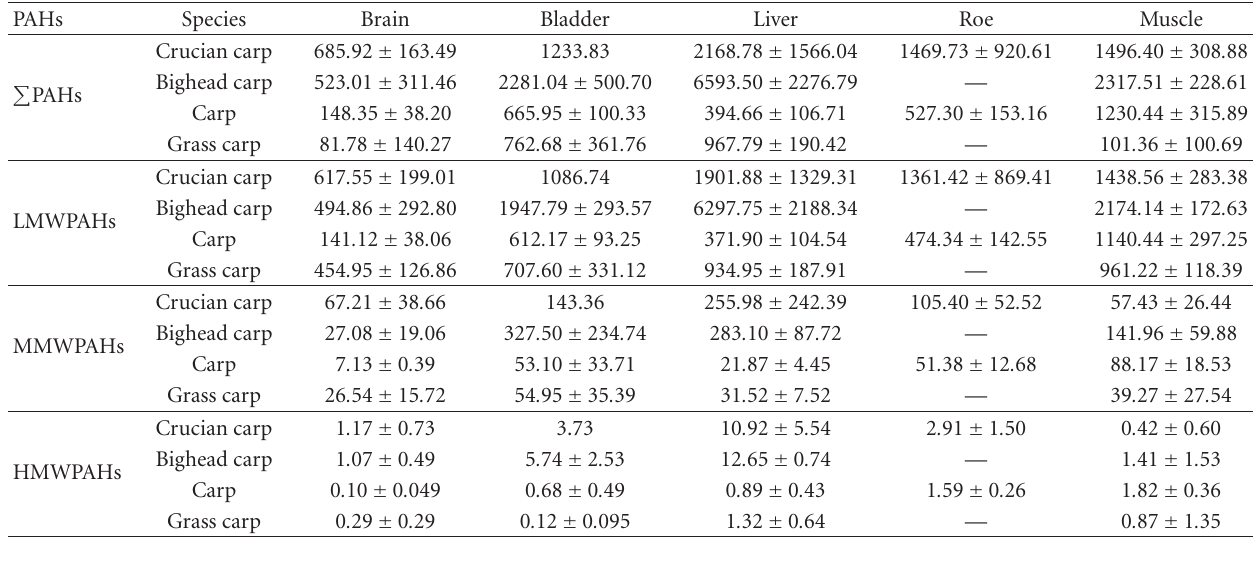
Table 5: Residual levels of PAHs (lipid normalized) (ng · g − 1 lw) in freshwater fish samples.